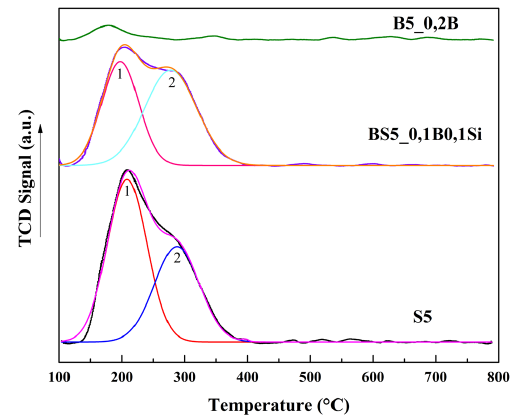
profiles of AFI samples obtained at different 3